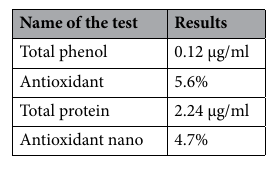
Table 1. Phytochemical screening of cow dung extract.